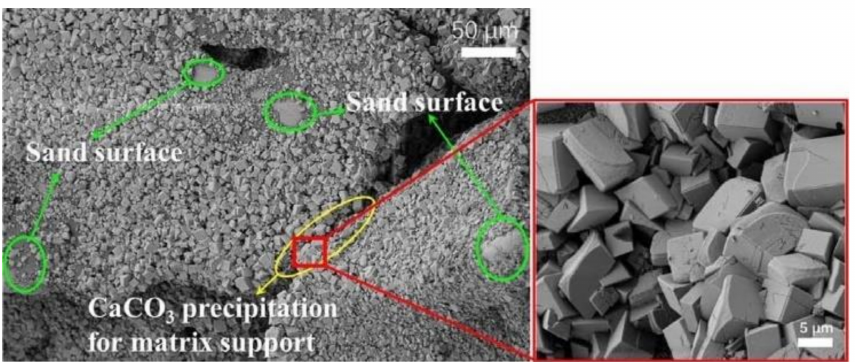
Figure 6. SEM graph of CaCO 3 crystals formed in MICP-treated samples